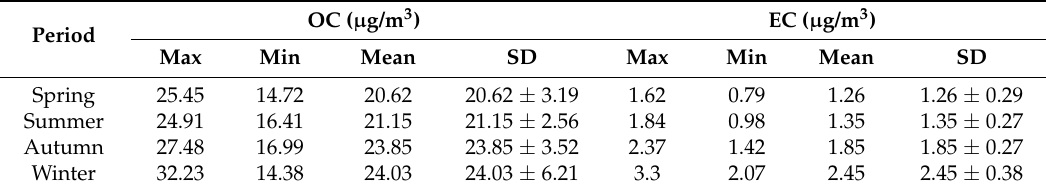
Table 3. OC and EC contents in different seasons in Changchun.